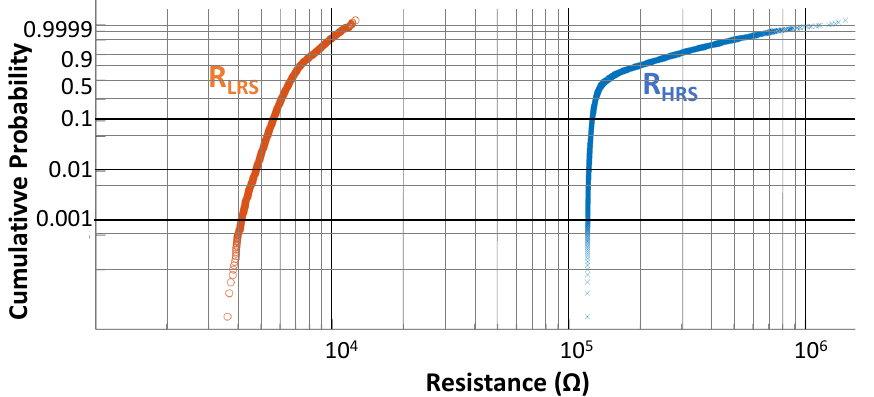
Figure 5. HRS and LRS resistance distribution measurement results after cycling the memory array 500 times.